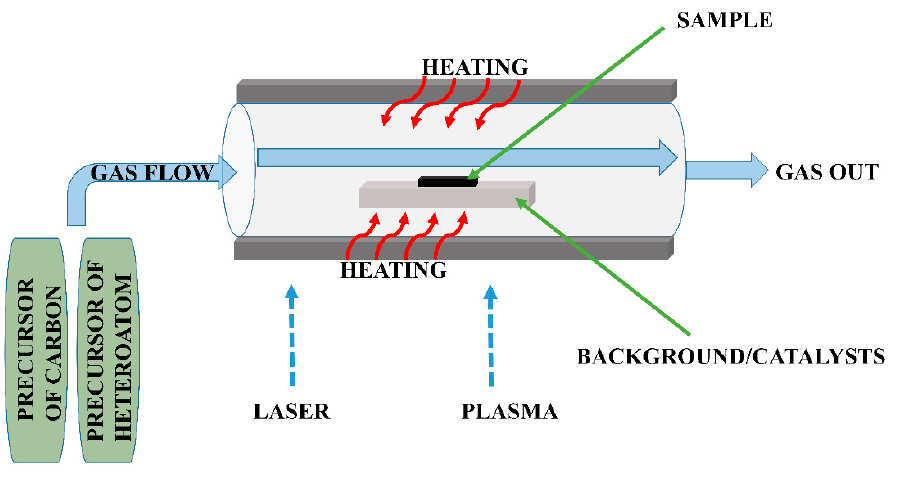
Figure 6. Schematics of synthesis chemical vapor deposition method. Table 3. Summary of nitrogen-doped graphene synthesized via the CVD method as an electrocatalyst for